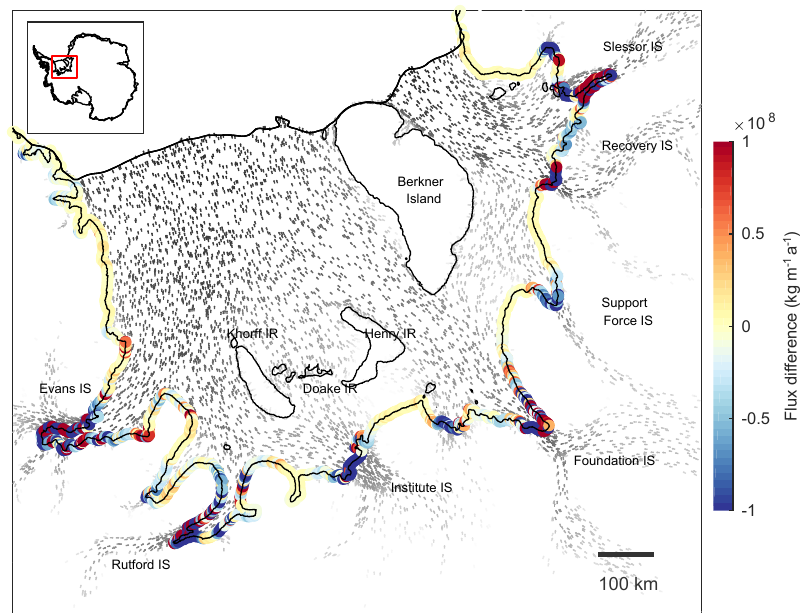
Figure B2. Difference between formula-derived and modelled fluxes along the grounding lines of Filchner–Ronne Ice Shelf. In contrast to Fig. 5 a different mesh was employed (exemplified in the right panel in Fig. B1), the data assimilation was conducted using Bayesian inversion and based on the MEASURES velocity data set (Rignot et al., 2011). The analysis was done using quadratic elements. This Antarctic-wide set-up is described in more detail in Reese et al.